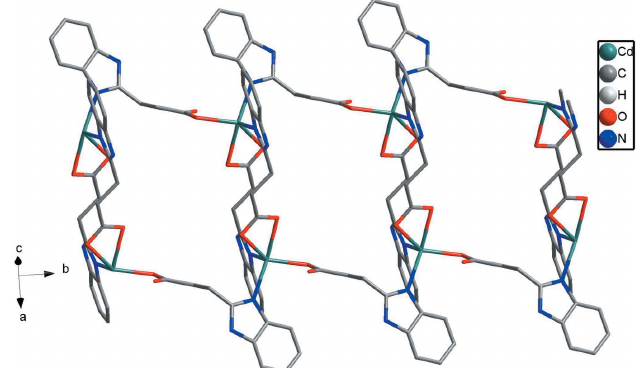
Figure 4 The asymmetric unit of 2 , with additional symmetry-related atoms. The displacement ellipsoids are drawn at the 30% probability level [symmetry codes: (A) (cid:2) x , (cid:2) y , (cid:2) z + 1; (B) x , y (cid:2) 1, z ].